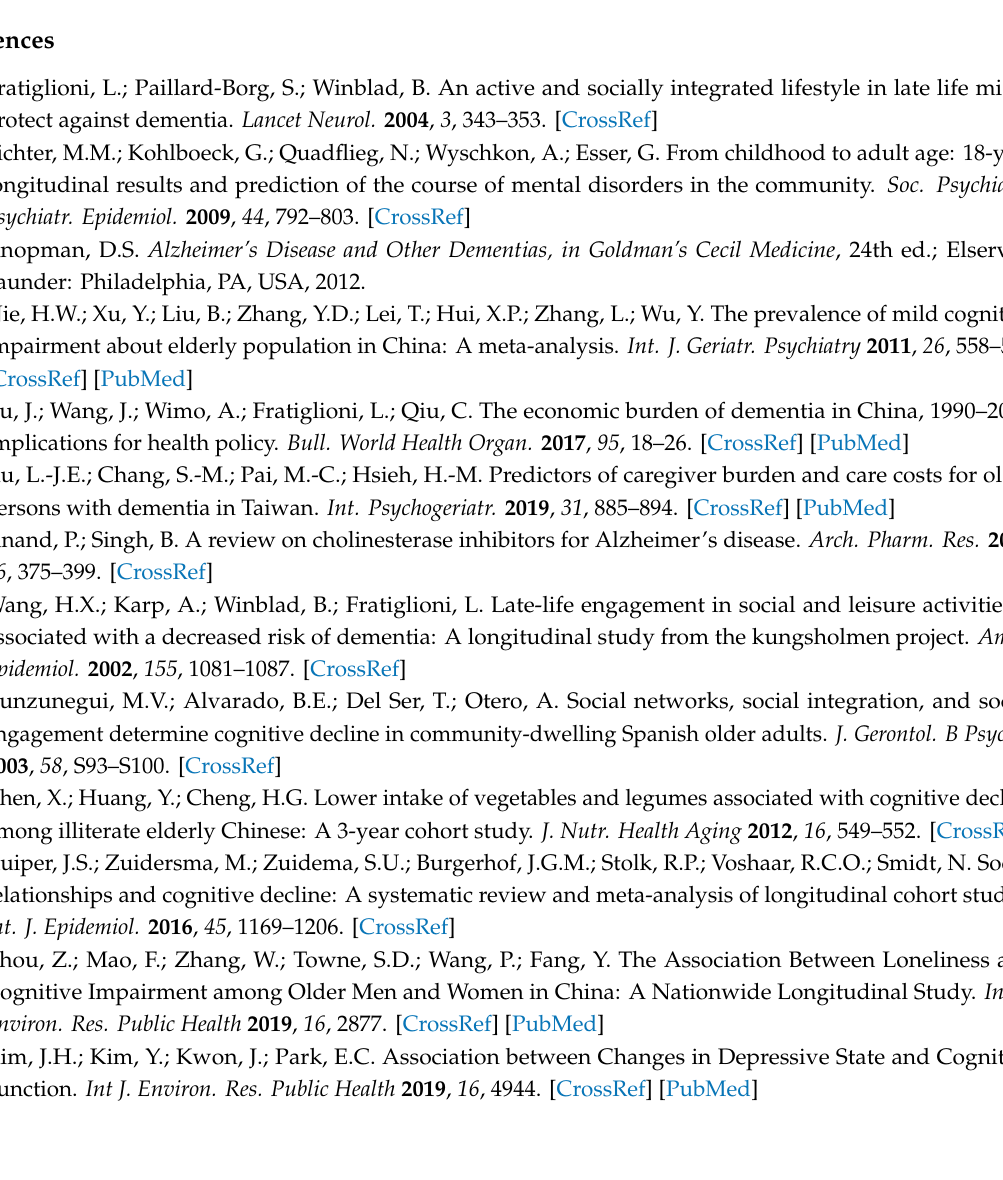
Table S1. Cognitive impairment risks under hypothetical interventions among di ff erent age groups, Table S2. Cognitive impairment risks under hypothetical interventions among di ff erent gender groups, Table S3. Cognitive impairment risks under hypothetical interventions in di ff erent education